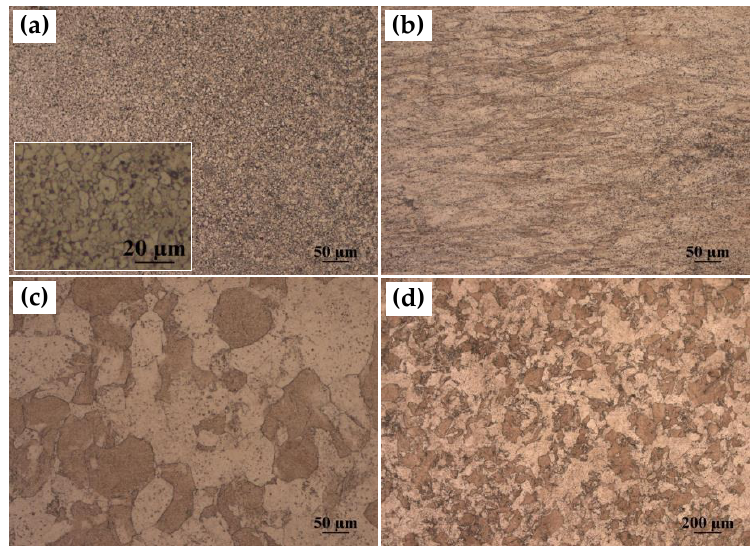
Figure 2. Metallograph of the hot-pressed WTC ( a ), thickness direction of HERFed WTC ( b ), and radial direction of HERFed WTC ( c , d ). The fracture surfaces of the as-forged and as-sintered WTC samples at RT observed with SEM are shown in Figure 3a,b. The fracture modes of the as-forged and as-sintered samples are markedly different. The forged and sintered samples are essentially ruptured in transgranular cleavage and intergranular fracture modes, respectively. The grain shape of the forged WTC specimen presents a long strip shape, whereas the equiaxed grains are dominant to the sintered specimen. Given that second-phase particles in tungsten alloy play a very important role, tungsten matrix should be inspected for the existence of TaC particles. The EDS results shown in Figure 3c demonstrate the presence of TaC particles. The red ar- rows in Figure 3a indicate the positions of some TaC particles in the tungsten matrix.